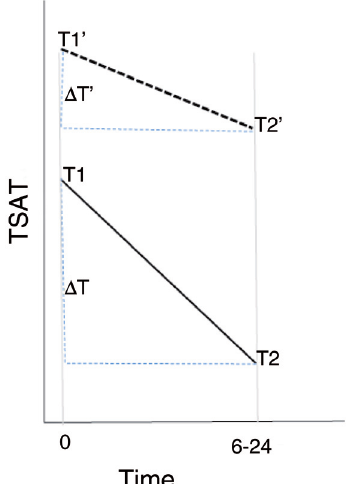
Figure 4. An example of hypothetical scenario for TSAT values between the groups to be compared. In this example: (i) Time 0 refers to average cord blood levels (ii) Time 6–24 refers to the mean level in the 6–24 hour period after birth. (iii) T1, T2, represent TSAT in 1 and 2 above and Δ T=T2-T1 for full term, normal birthweight (Group D) (iv.) T1’, T2’and Δ T’=T2’-T1’ same as above but for the premature, low birthweight (Group A). Hypothesis: H T2=T2’ vs. H : T2 ≠ T2’. A